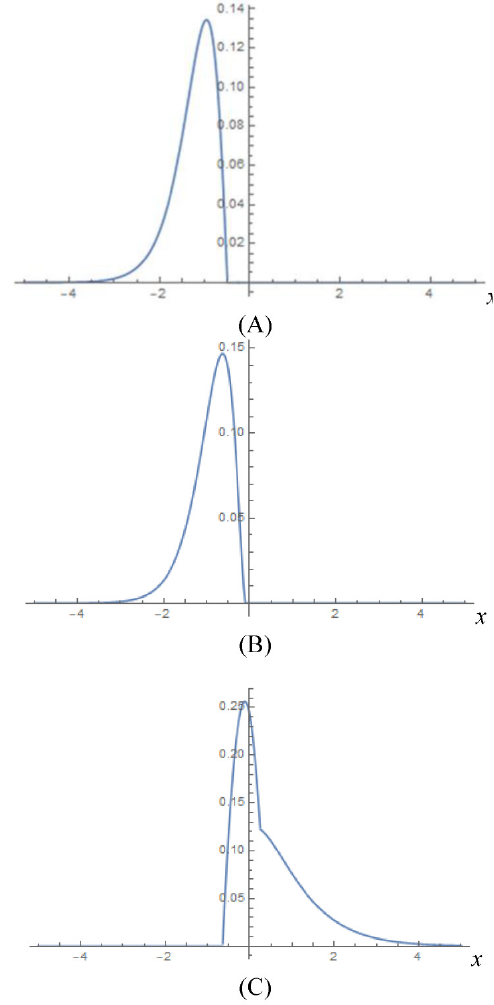
Figure 3. The shape of the pulse in arbitrary units (a response to the delta function) in the cases ( A ) τ = x / c − 0.5 a , ( B ) τ = x / c − 0.25 a , and ( C ) τ = x / c + 0.25 a . The spatial coordinate is measured in the units c · a (see Equation